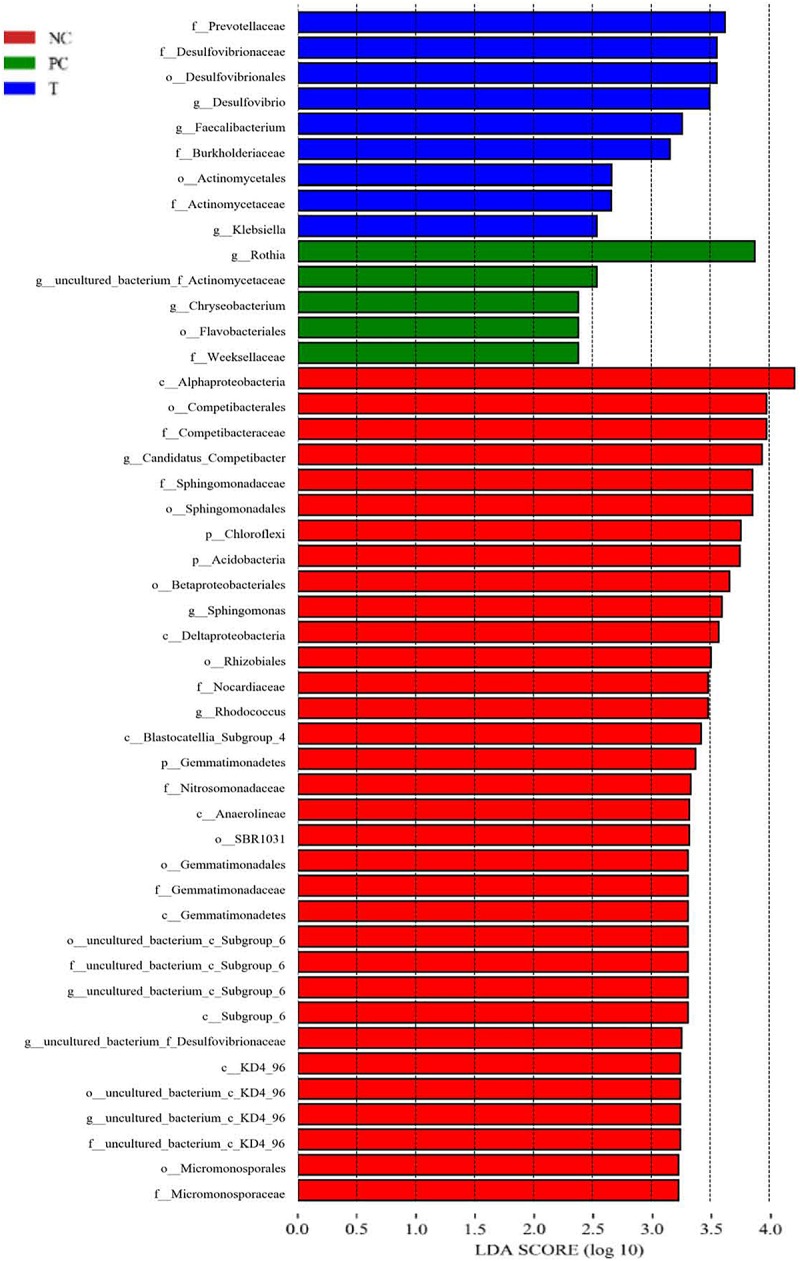
Linear discriminant analysis (LDA) combined effect size measurements (LEfSe) analysis of ileal microbiota in laying hens at 3 days post S. pullorum infection. Species with significant difference that have an LDA score greater than the estimated value (2.0). The length of the histogram represents the LDA score. NC, negative control (birds were free of challenge); PC, positive control (birds were challenged with S. pullorum at the end of week 4 of the experiment); T, treatment group (PC + plant extracts addition at 1000 mg/kg).